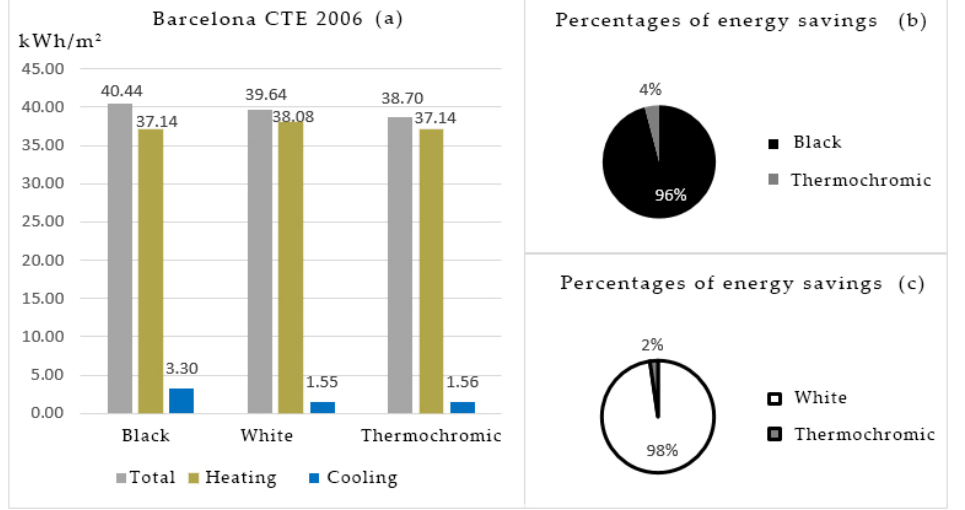
Figure 11. ( a ) Energy demand for heating and cooling in the case of Barcelona CTE 2006. ( b ) Thermochromic vs. black surface finish energy savings. ( c ) Thermochromic vs. white surface finish energy savings.